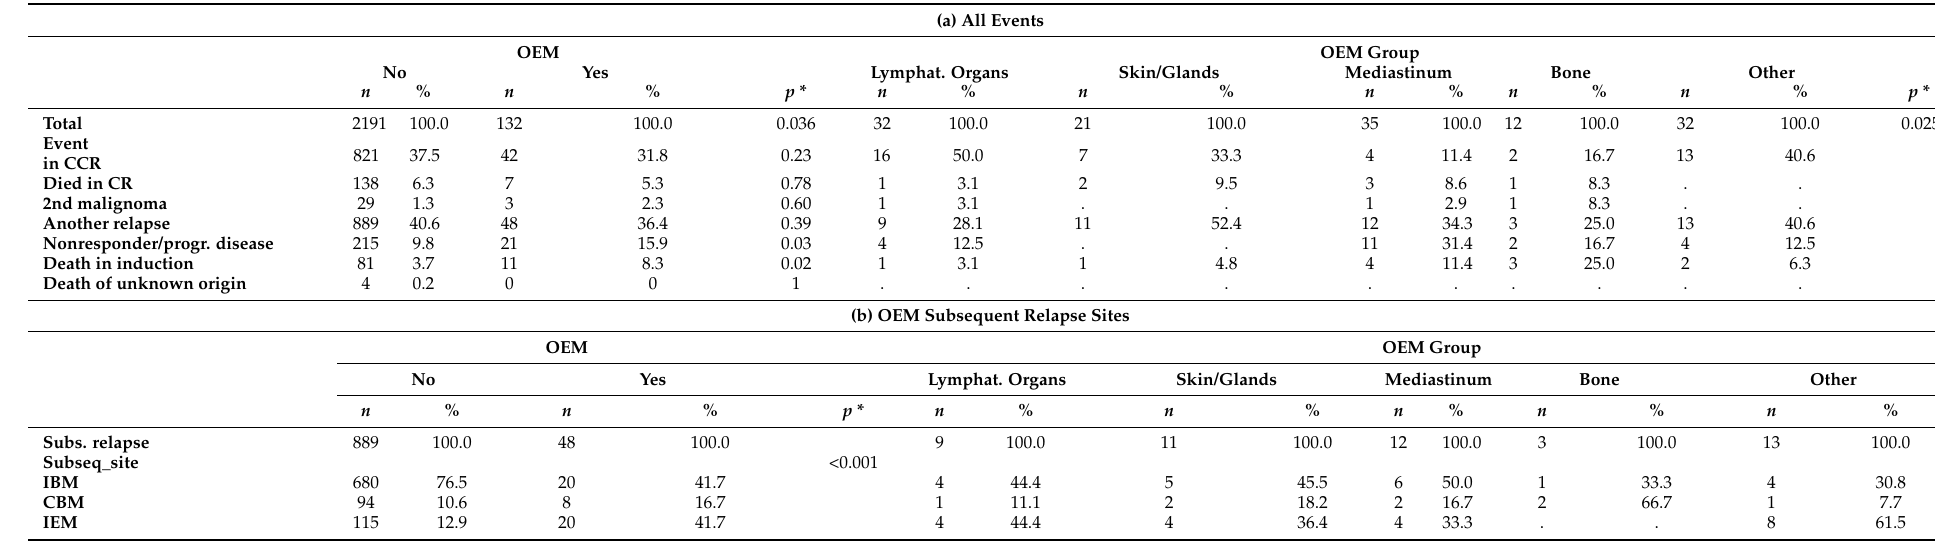
Table 3. Events within the OEMR